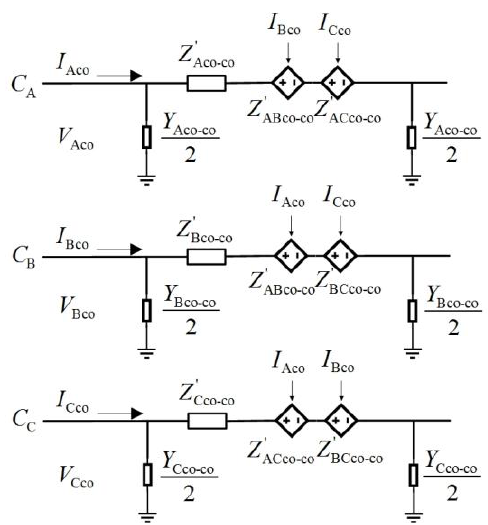
Figure 8. GIL simplified model based on PI-model.